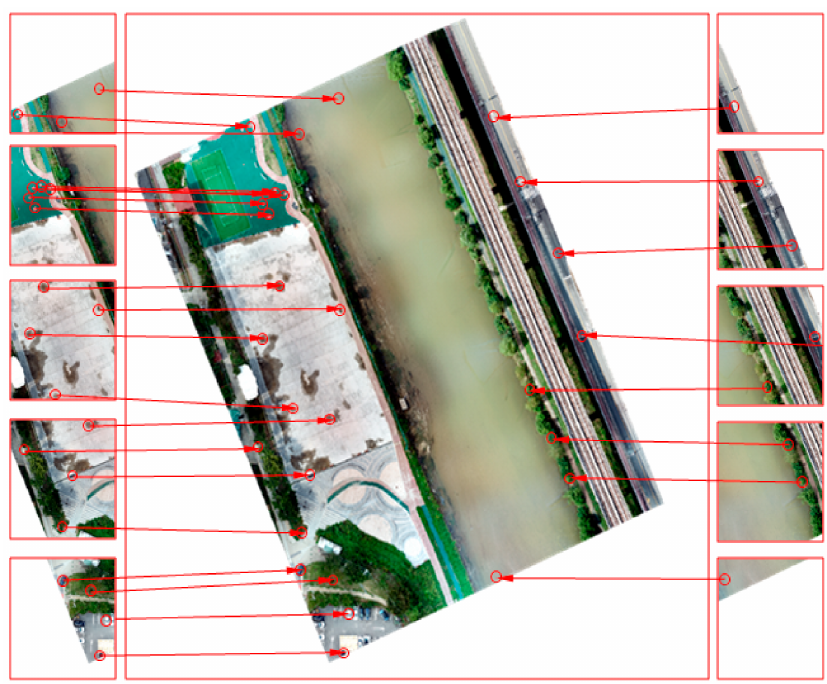
Figure 6. Schematic of 2D image